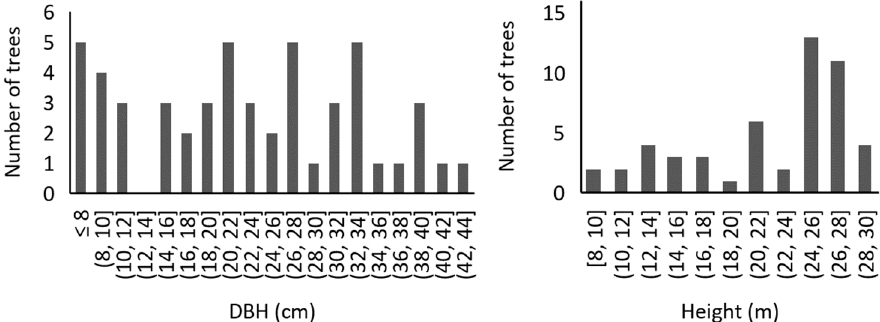
Figure 2. Number of trees in DBH and height classes (interval of the class is 3 cm and 3 m, respectively) within the experimental plot area (608 m 2 ).